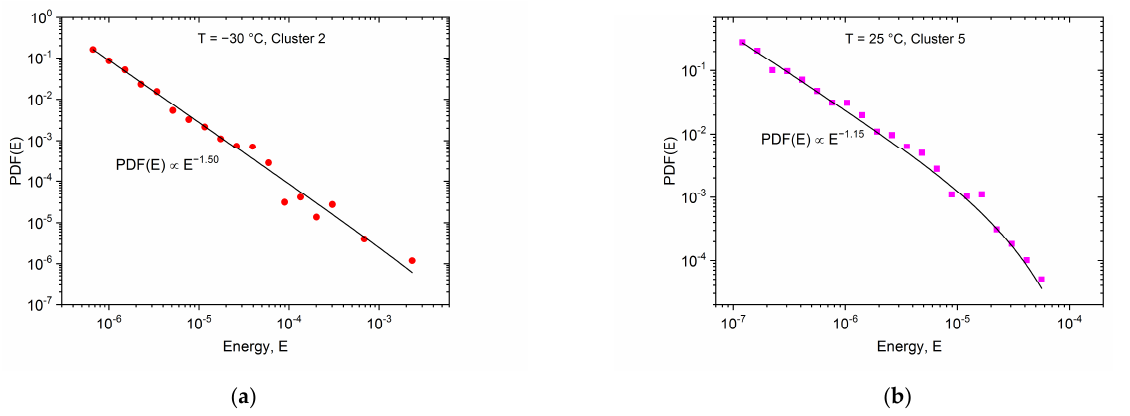
Figure 9. Probability density functions of the avalanche energies for Cluster 2 ( a ) and for Cluster 5 ( b ).